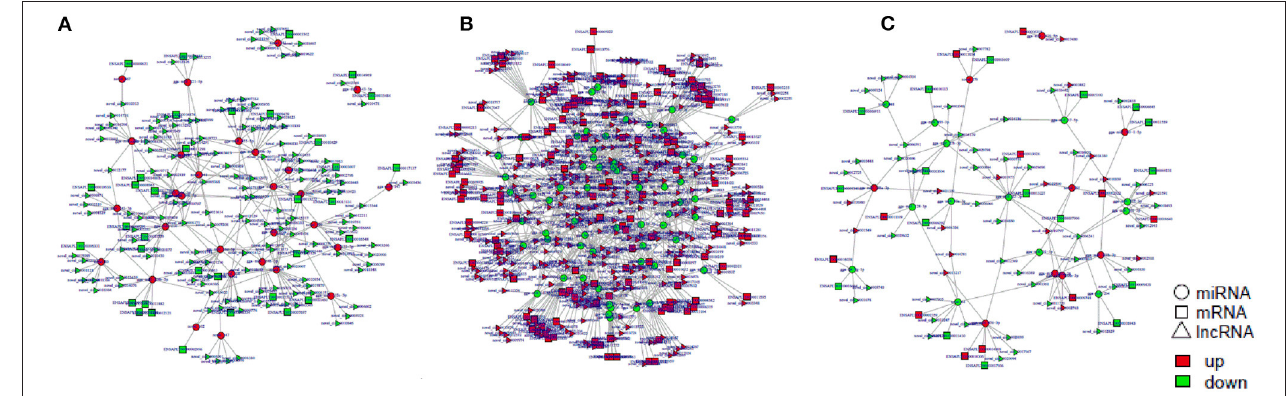
FIGURE 11 | The regulatory networks of circRNA-miRNA-mRNA during SE infection in duck granulosa cells. (A) circRNA-miRNA-mRNA interaction network of 3 vs. 0 hpi group. (B) circRNA-miRNA-mRNA interaction network of 6 vs. 0 hpi group. (C) circRNA-miRNA-mRNA interaction network of 6 vs. 3 hpi group.